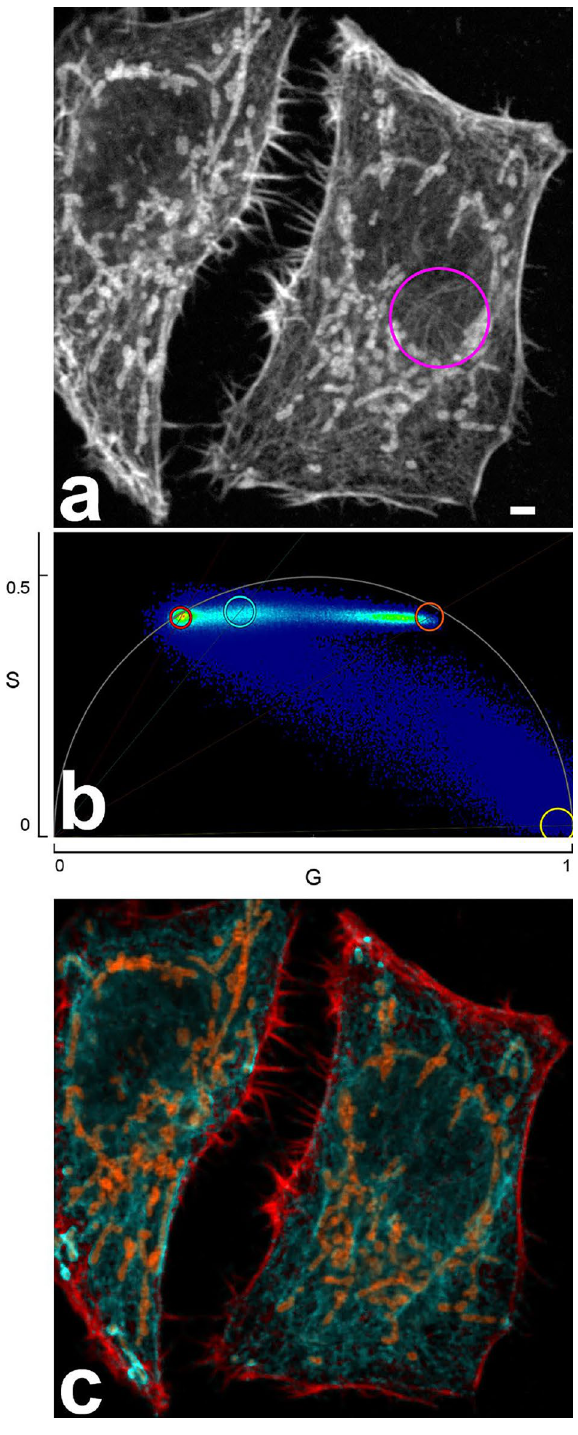
Figure 5. Three fluorochromes in the same spectral range with different lifetimes cannot be separated with high quality by the phasor approach. ( a ) Confocal raw image with Abberior STAR 635P labeled vimentin, Alexa Fluor Plus 647 labeled mitochondria and ATTO 647N labeled actin. Scale bar 2 µm. Magenta circle highlights some delicate vimentin fibers. ( b ) Phasor plot of this image. The lifetime components are indicated by circles: ATTO 647N-actin red, Abberior STAR 635P-vimentin cyan, Alexa Fluor 647-mitochondria orange. A background component (yellow circle) was also included for phasor separation to suppress noise. In pixels with a low photon count, noise from reflection and other sources will determine the average lifetime of the pixel, making it likely to be sorted with the background component. ( c ) Phasor separated image, same color code. Note the poor preservation of delicate vimentin fibers in the circle in ( a ). The respective pixels were not correctly assigned to the vimentin